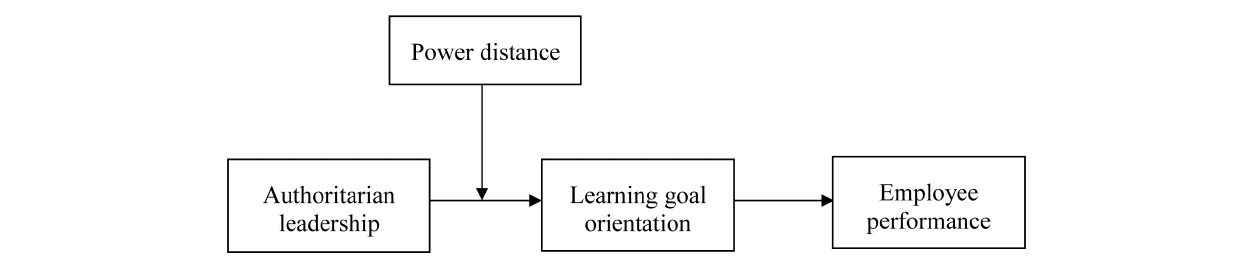
FIGURE 1 | Theoretical